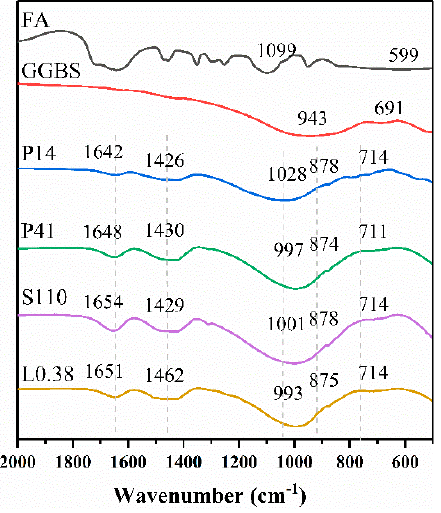
Figure 8. FTIR spectra of group P14, P41, S110 and L0.38.